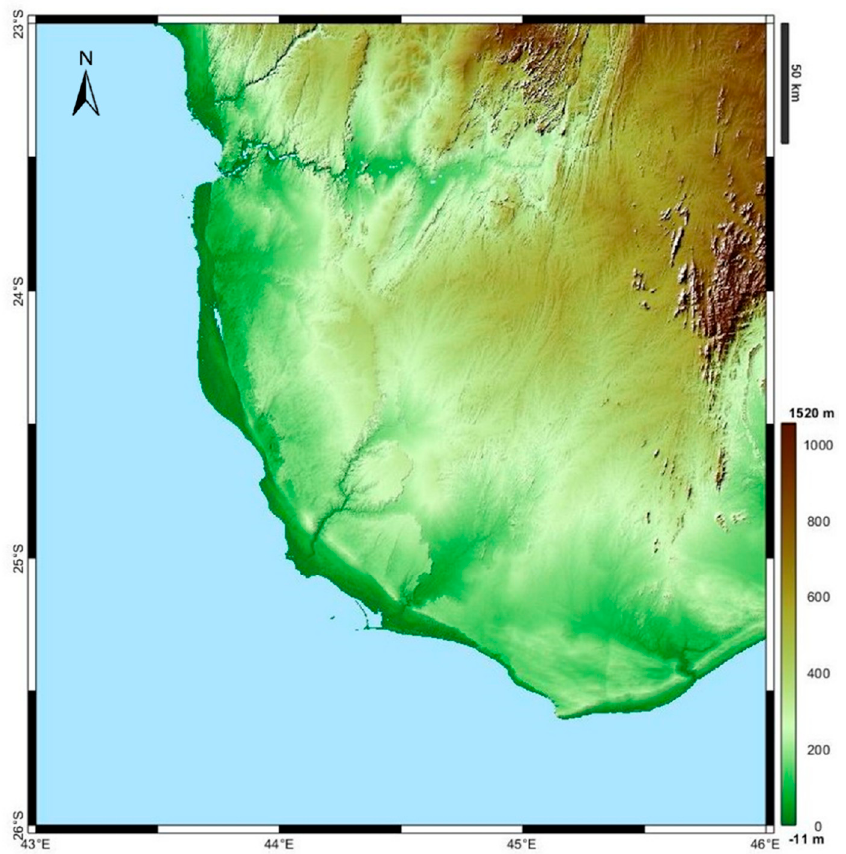
Figure 3. Digital elevation model of the great south western part of Madagascar (source: Shuttle Radar Topography Mission (SRTM).